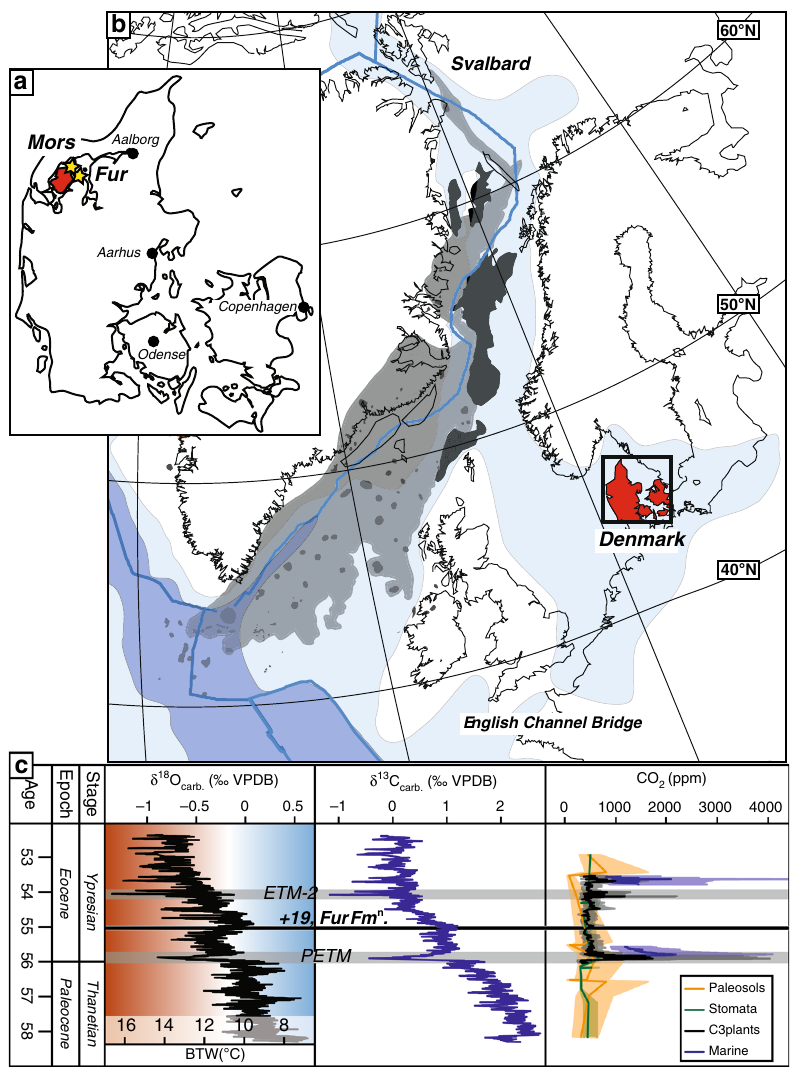
Fig. 1 Summary of relevant geographical and geochemical data. a current geographic map of the study area. b Paleogeographic reconstruction of the North Sea Basin and surrounding regions, made using the paleomagentic reference frame 15 ; NAIP and other details from Jones et al. 18 . c Position of Fur Formation ( + 19 horizon), in relation to the Eocene hyperthermals 53 , stable C- and O- isotope records 55 , and reconstructed p CO 2 54 . Geological timescale of Ogg et al. 85